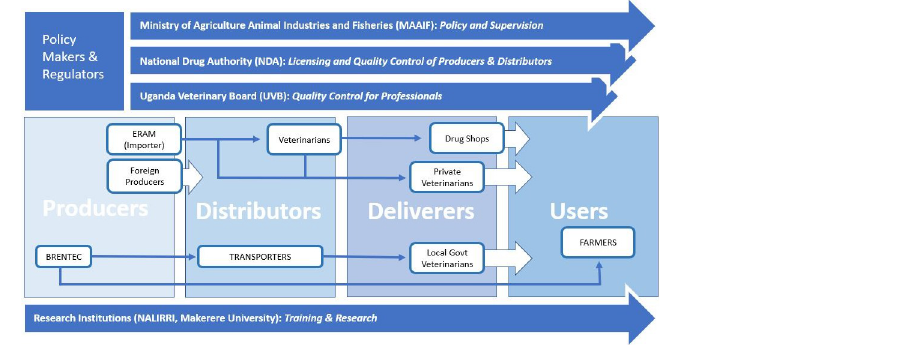
Fig 4. Private sector-led ND vaccine value